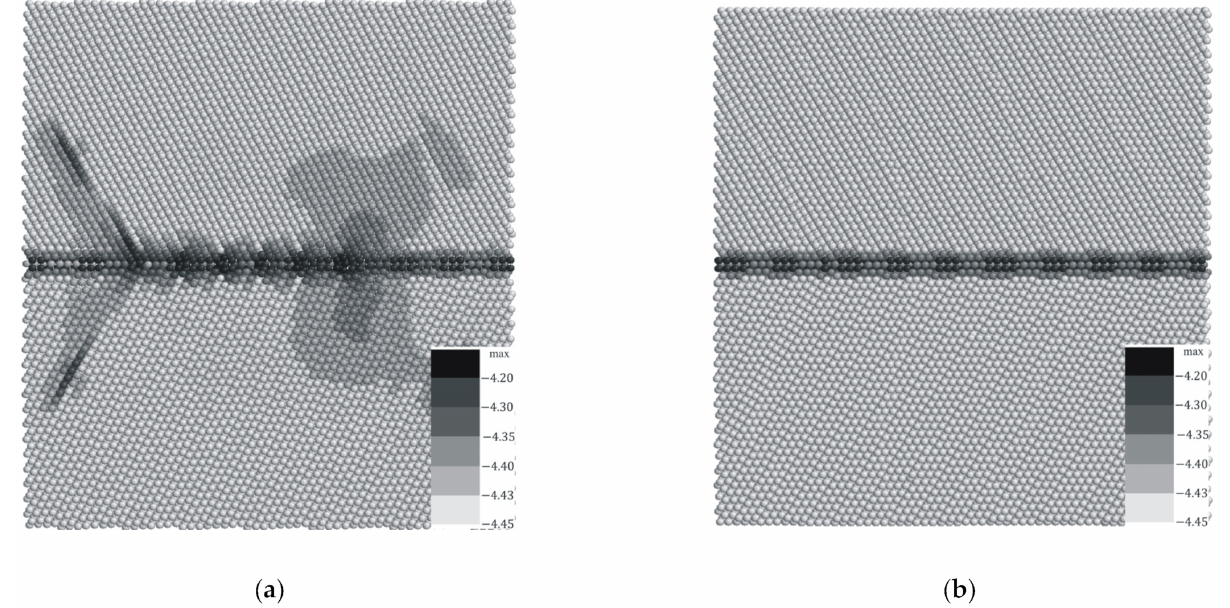
Figure 22. Stress maps of a bicrystal containing a disclination dipole ( a ) and with a relaxed structure after five cycles of loading with a stress amplitude of 500 MPa ( b )